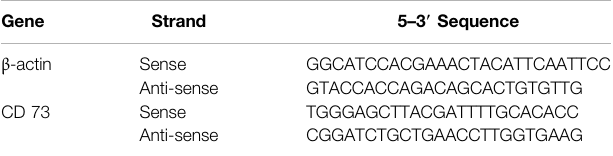
TABLE 1 | Primers used for real-time quantitative reverse transcription- polymerase chain